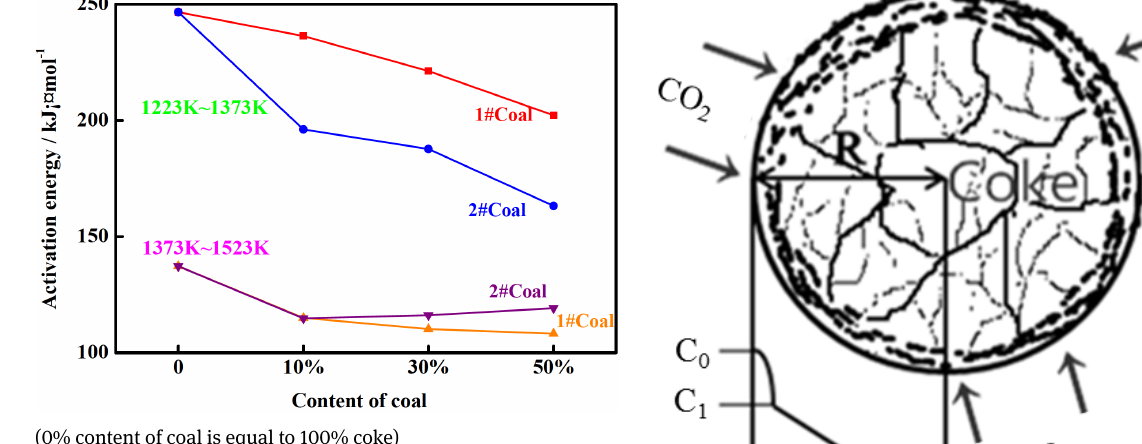
action model. During the reaction, the particle size does not change, and the core does not react, but the reaction interface continues to push toward the core. For the solid materials with high porosity or the ore balls, we usually use the porous volume-reacted model. In porous volume- reacted model, while the reactive gases are diffused into the solid materials with high porosity, they also take place the chemical reaction in the pore. That is to say, the dif- fusion and the chemical reaction are processed simultane- ously. When the unburned pulverized coal is attached to the surface of the porous coke, the model of coke solution loss reaction is shown in Figure